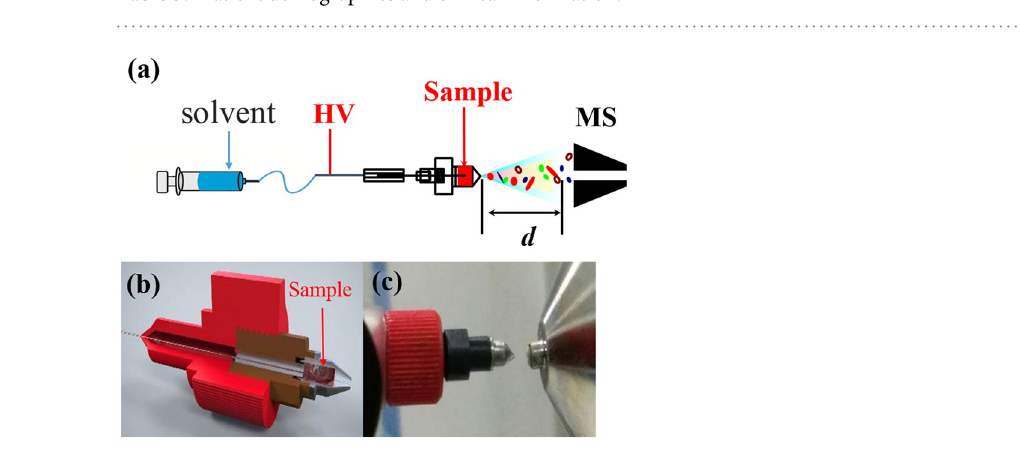
Figure 5. The iEESI-MS source. ( a ) Schematic diagram of iEESI-MS: Signals of the interior analytes were captured when the solvent was delivered from an infusion pump at a flow rate 0.5 μ L·min − 1 and supplied with a high voltage + 4.5 kV. ( b ) Cross-sectional drawing of the iEESI-MS source. ( c ) Physical map source of iEESI-MS. HV is high